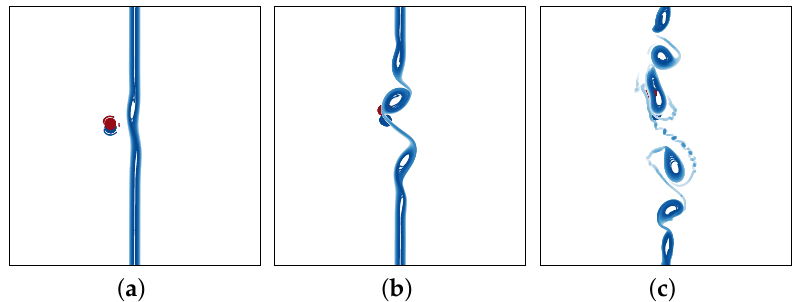
Figure A1. Case similar to case 1 but in a computional domain effectively twice as large. Top view of the flow showing contours of buoyancy and PV at t = 14, 26 and 40 from ( a ) to ( c